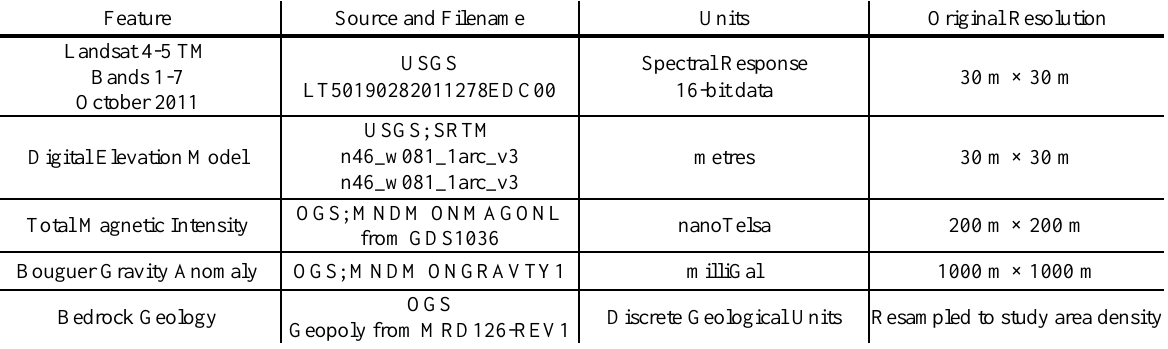
Table 1. Summary of data, features for classification and validation, and class label inputs. Includes source, units, and original